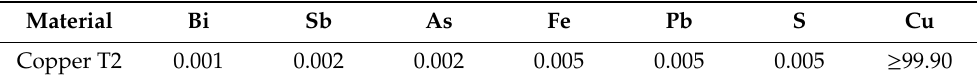
Table 2. Chemical composition (wt.%) of the Cu-T2.